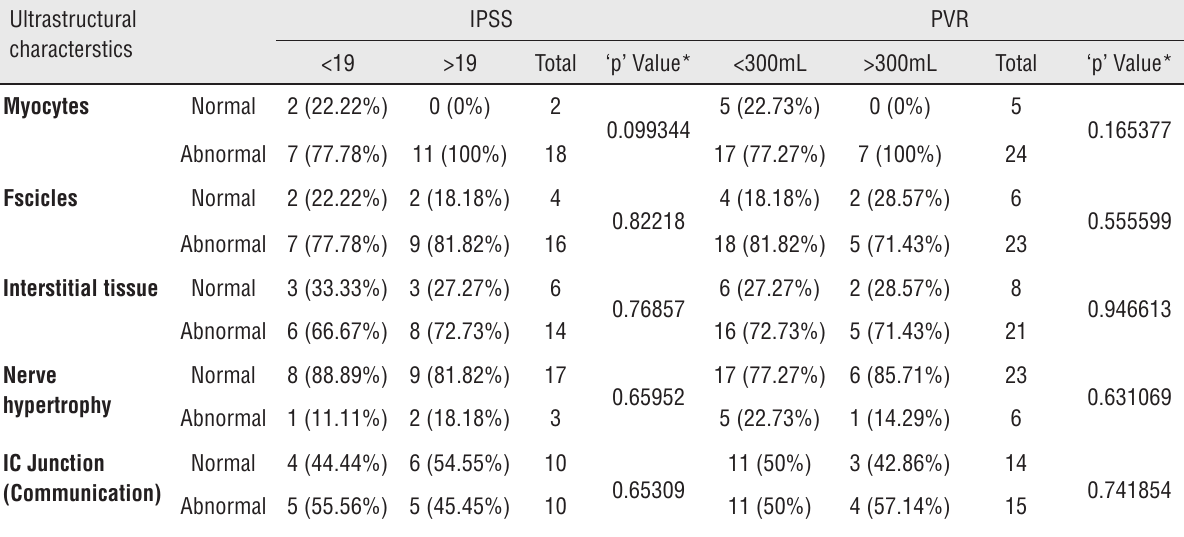
Table 4 - Showing correlation of ultrastructural characterstics with IPSS and PVR. Ultrastructural